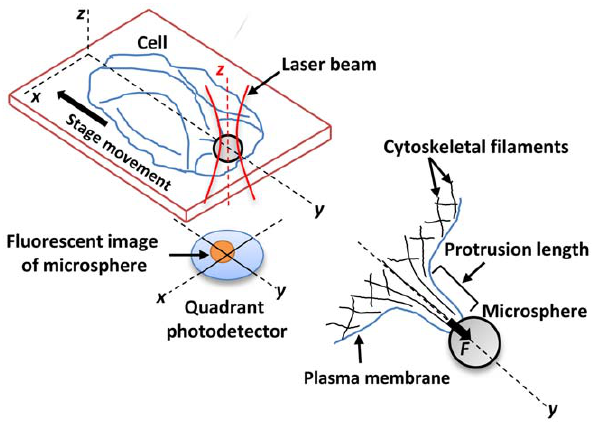
Figure 1. Schematic of a protrusion induced on an adherent living cell using optical tweezers. The protrusion forms in response to application of a tensile force ( F ) on the cell surface in y direction by a laser trapped microsphere (bead) (drawn not to scale). A quadrant photodetector records the instantaneous displacement of the trapped microsphere from the trapping center for force measurements while the stage is driven in the negative y direction.